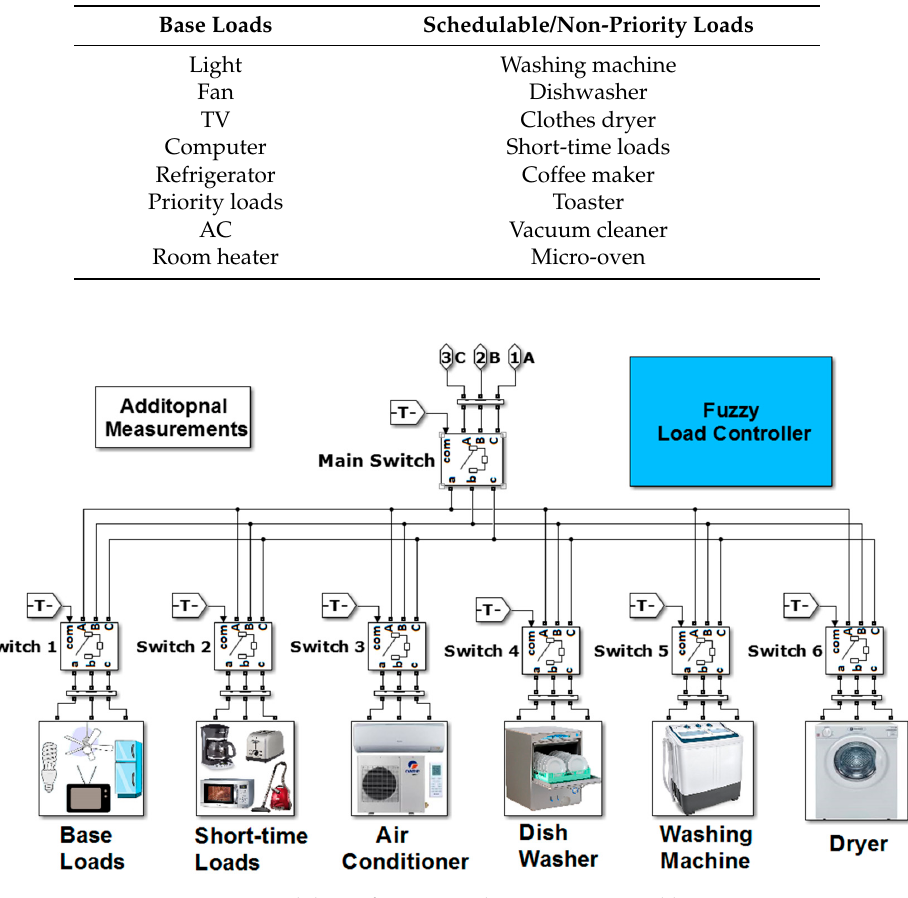
Figure 9. Modeling of major appliances in a typical house.